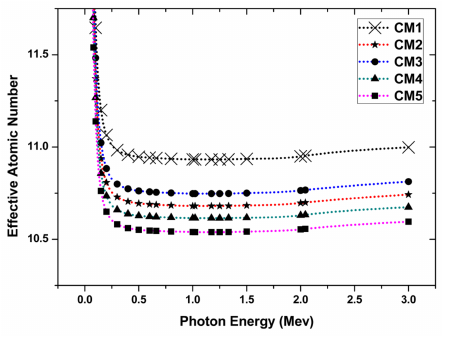
Figure 6: MFP and marble concentration at different energy lines.